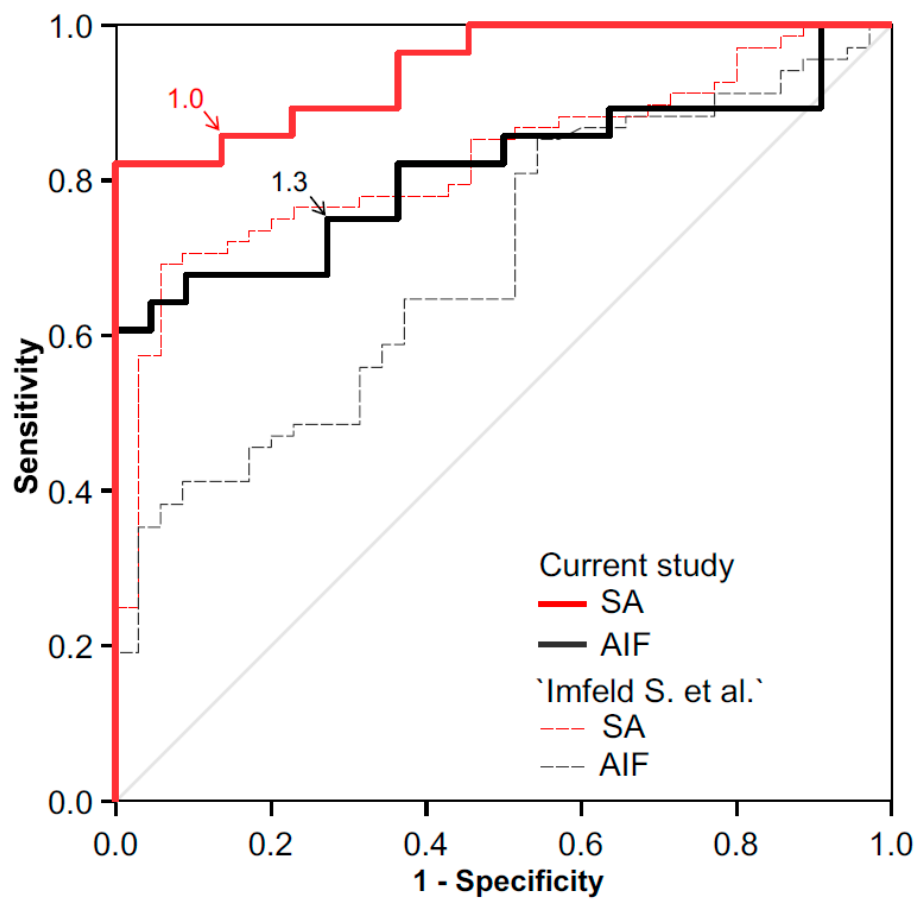
Figure 2. Receiver operating curves (ROC) of SUV vessel max /liver mean ratios for the supra-aortic (SA) and the aorto-iliofemoral (AIF) region. For comparison, ROC of the inception cohort Imfeld S. et al. [8] are displayed as thin dotted